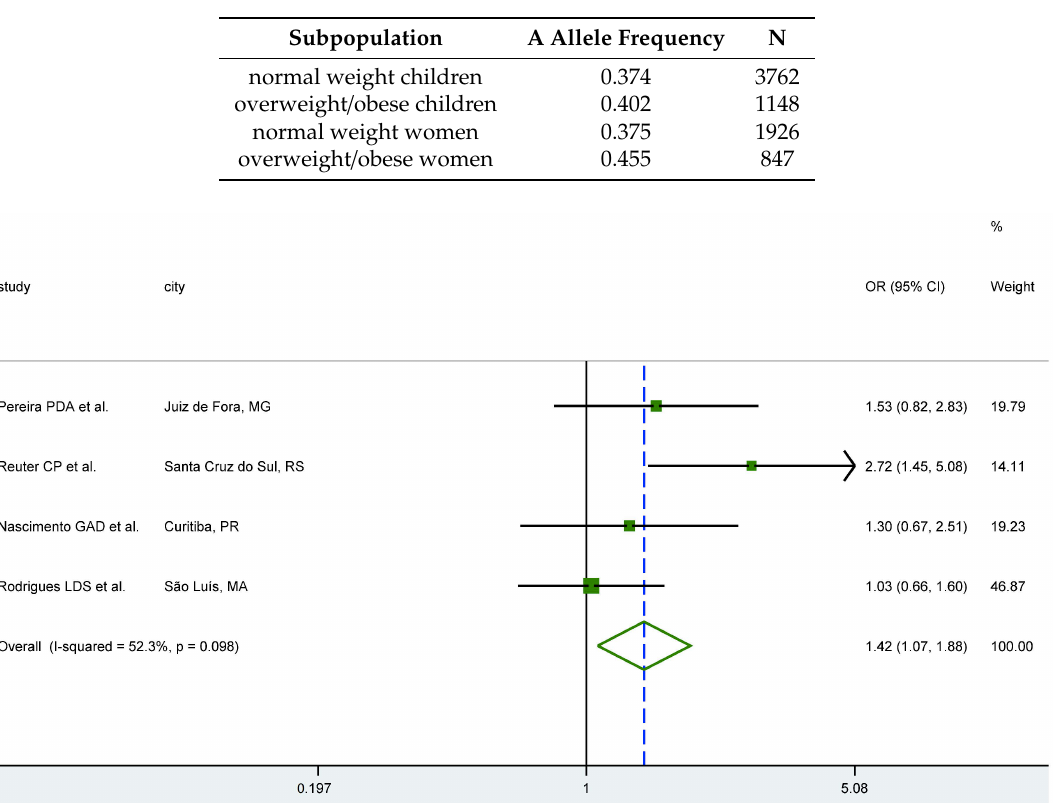
Table 1. Weighted frequency of rs9939609 A allele in subgroups of the Brazilian population.